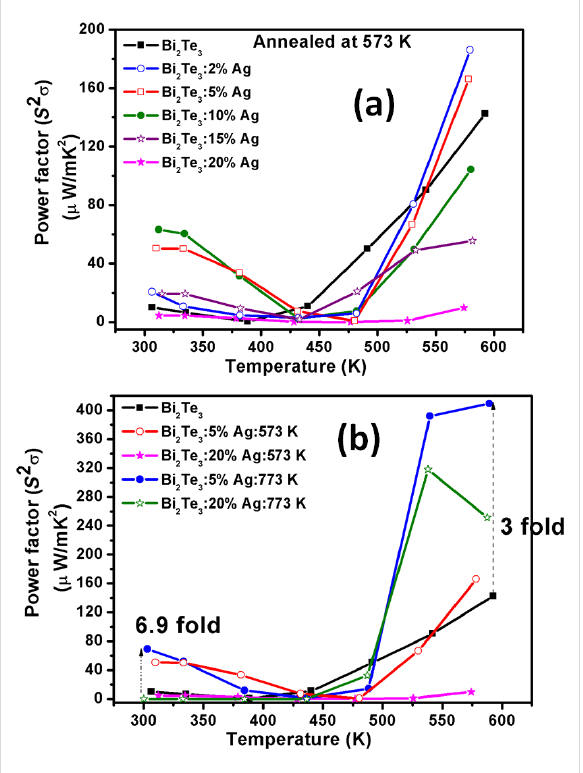
Figure 7: Power factor ( S 2 σ ) as a function of the temperature. (a) Bi 2 Te 3 with (0, 2, 5, 10, 15, 20%) Ag content annealed at 573 K, and (b) comparison of (0, 5, 20%) Ag content annealed at 573 and 773